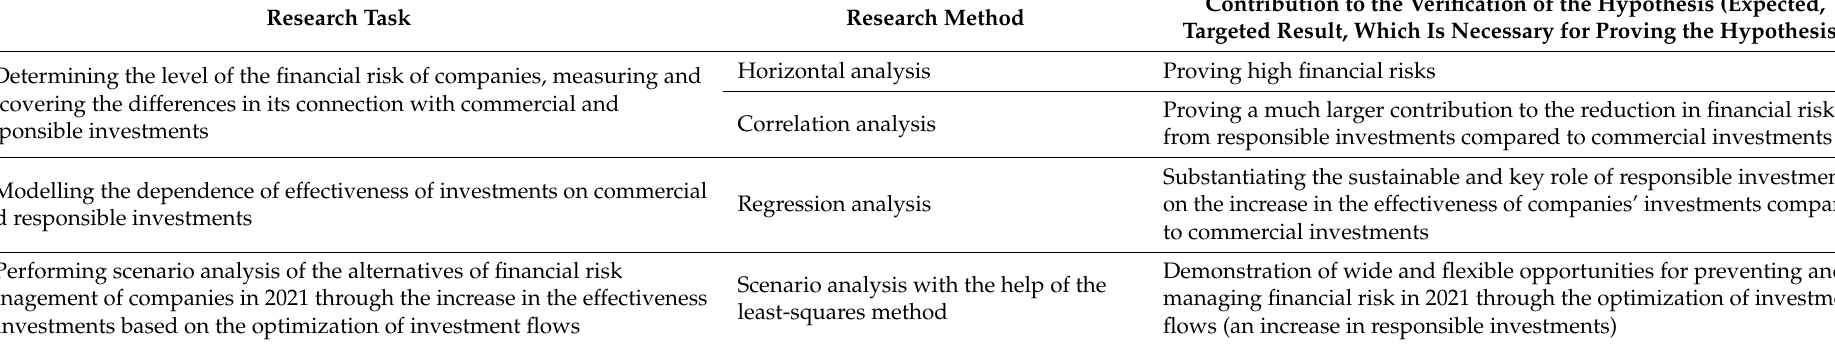
Table 2. The strategy of the